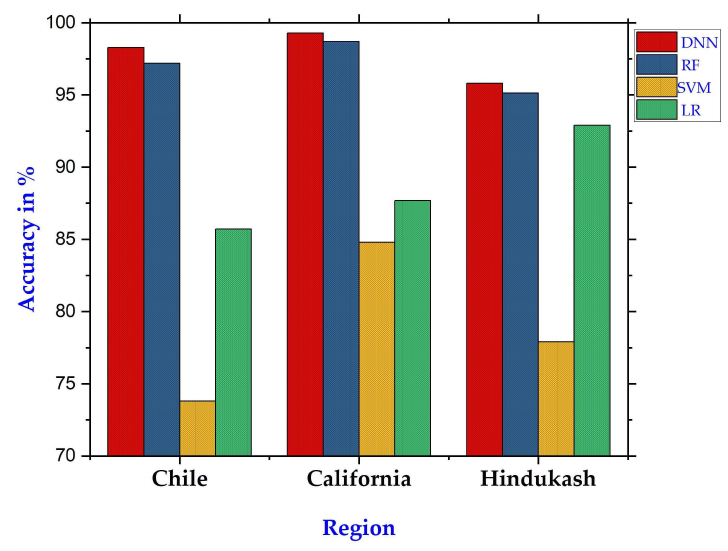
Figure 3. Overall accuracy score of all approaches on each dataset.